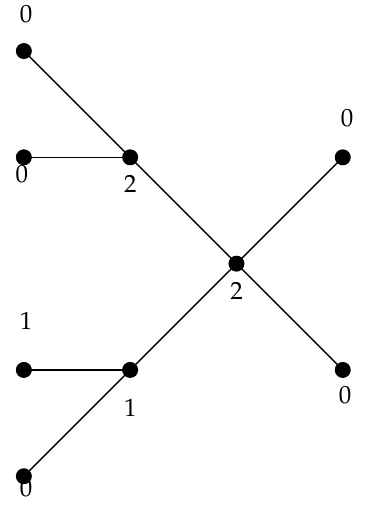
Figure 2. γ r ( T ) -function over a tree T , which is not a perfect Roman dominating function